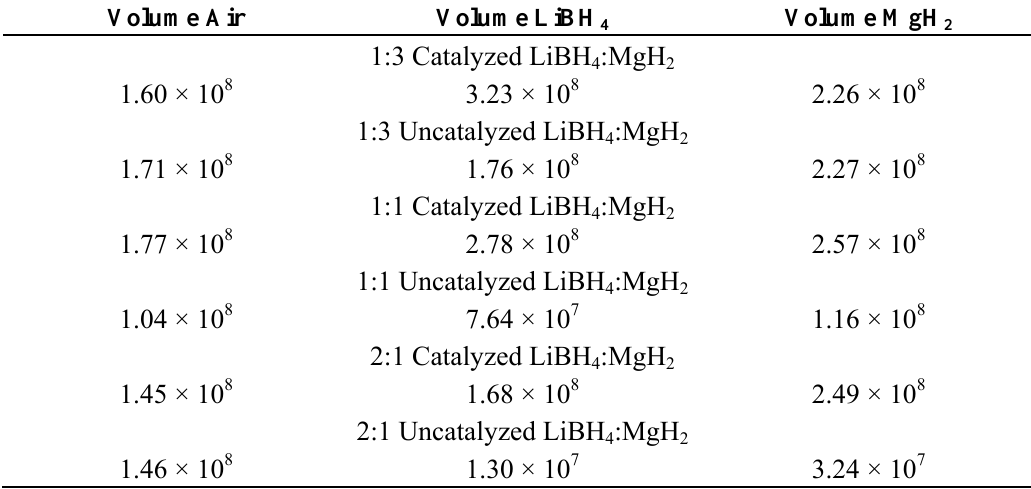
, and MgH (in  m 3 ) computed from pixel count 4 2 and MgH 4 2